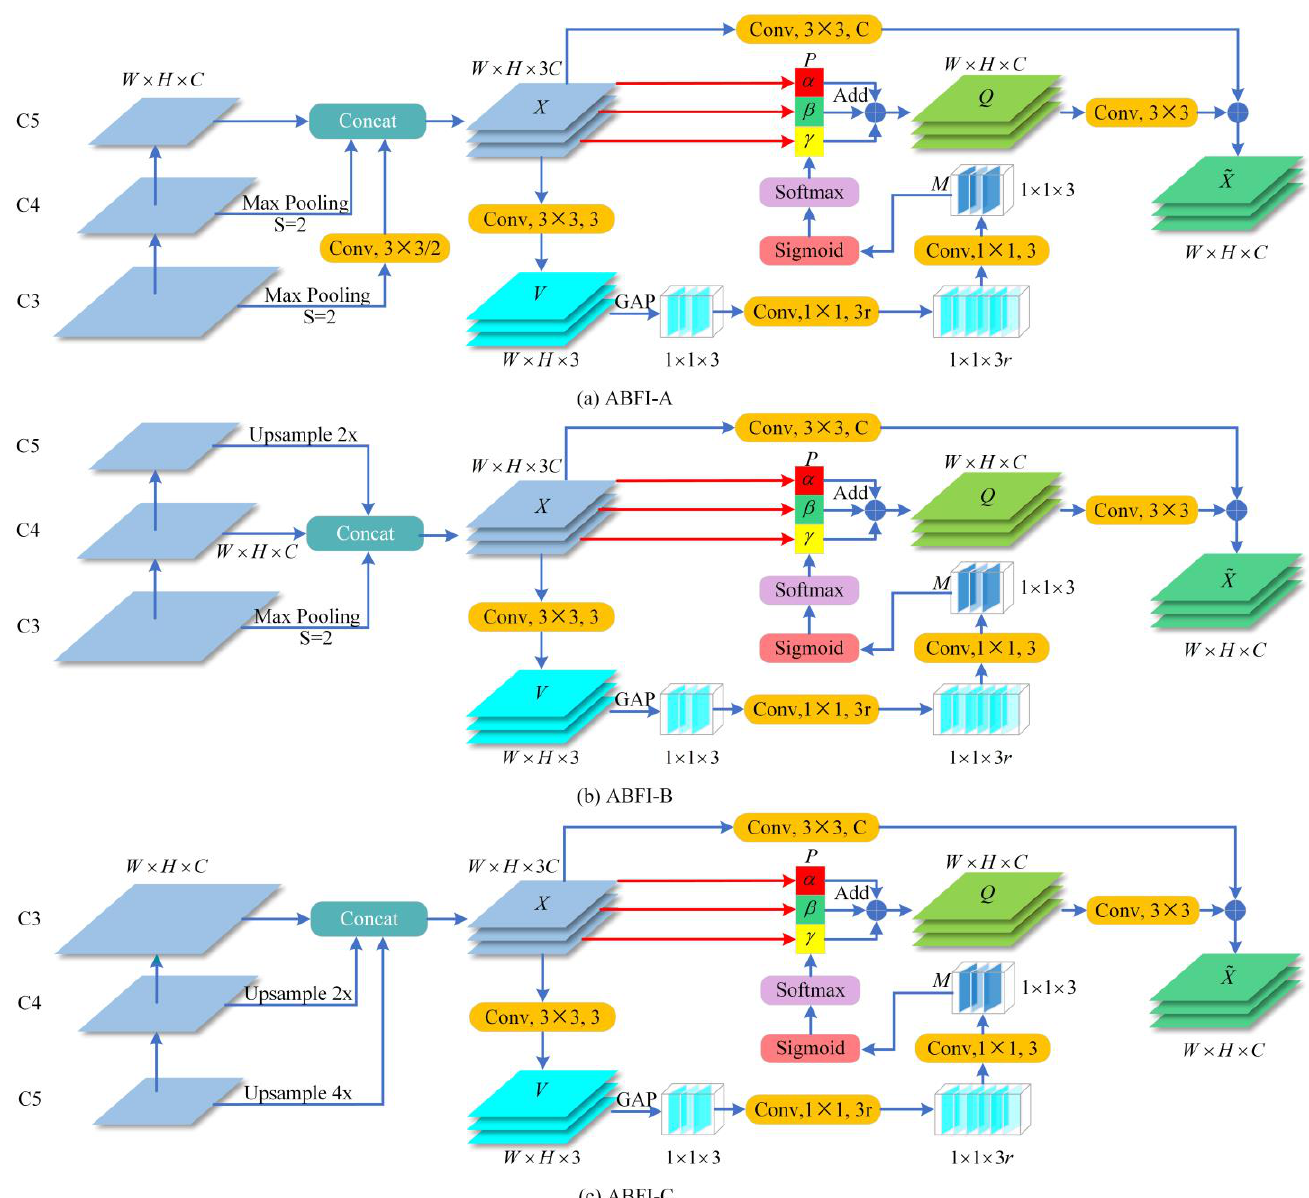
Figure 5. The pipeline of adaptive balanced feature integrated (ABFI) module. According to the different role positions, ABFI modules are divided into three types, namely ABFI-A, ABFI-B and ABFI-C, as shown in ( a – c ). GAP, Add and Concat mean global average pooling, addition and concatenation, respectively. Features at resolution level l are denoted as C l . r is denoted as the expansion factor. The red arrow is denoted as the multiply operation. (Conv, k × k/s, n) is denoted as the convolution operation, where k is the kernel size of convolution layer, s is the stride and n is the number of convolution kernels.